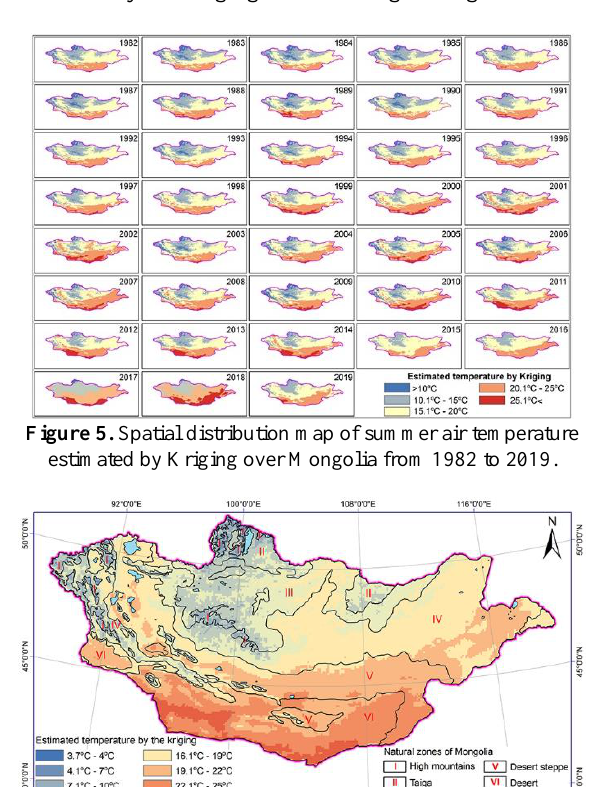
Table 2. Error statistics for RMSE and BIAS.